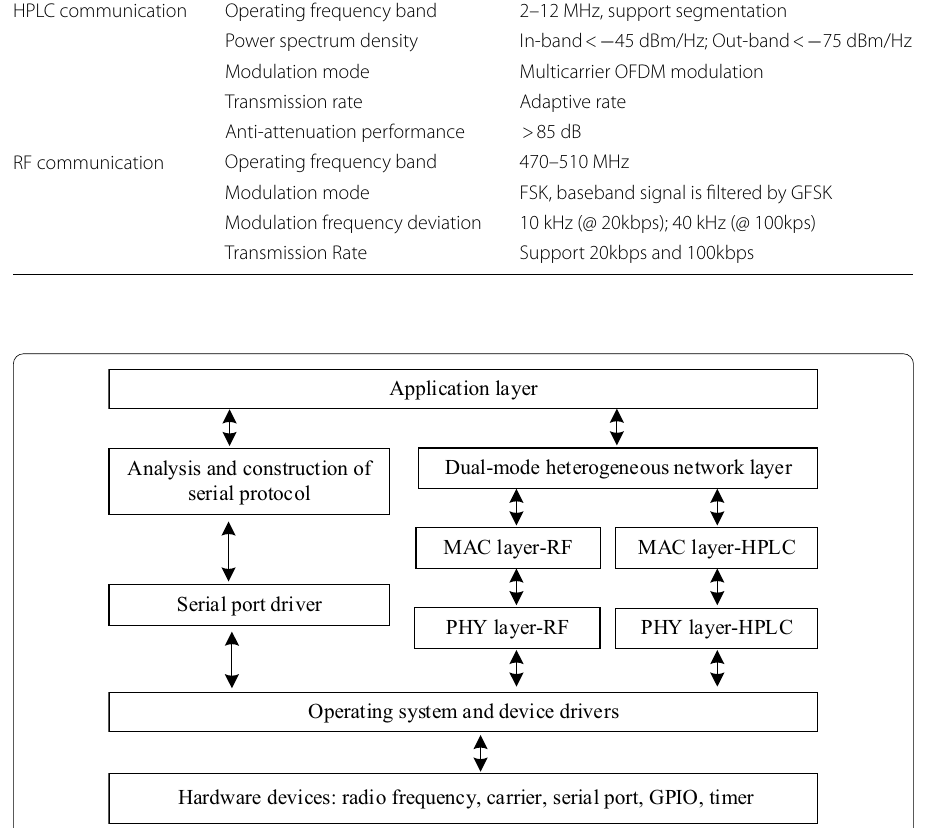
Fig. 3 the hierarchy of dual-mode communication protocol